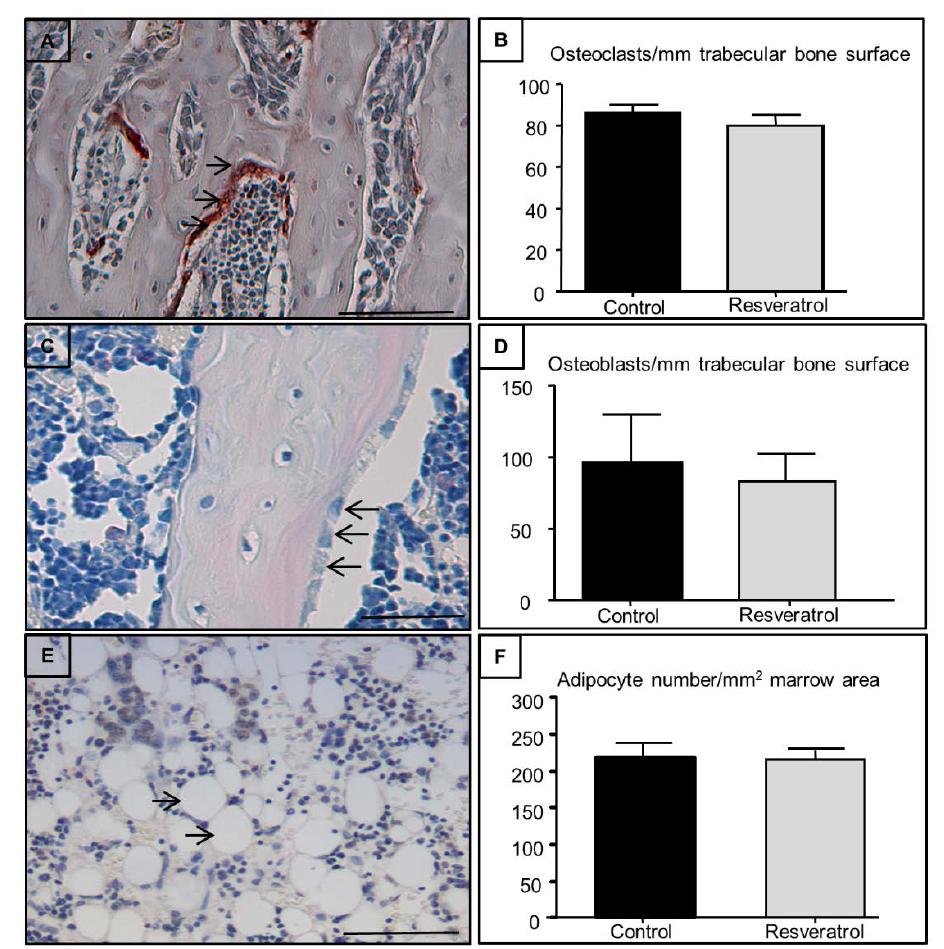
Figure 3. Effects of resveratrol supplementation on osteoclast, osteoblast, and adipocyte densities within the secondary spongiosa in early ageing rats. Histological analyses demonstrating ( A ) TRAP stained section of a control tibial bone showing stained osteoclasts (cells stained red containing three + nuclei as indicated by arrows) (bar = 100 μm); ( B ) Osteoclast density at the secondary spongiosa ( n = 7); ( C ) H & E-stained section showing osteoblasts in secondary spongiosa as indicated by arrows (bar = 125μm); ( D ) Osteoblast density within the secondary spongiosa ( n = 7); ( E ) H & E-stained section showing adipocytes in lower secondary spongiosa as indicated by arrows (bar = 100 μm); ( F ) Adipocyte density within the lower secondary spongiosa ( n =